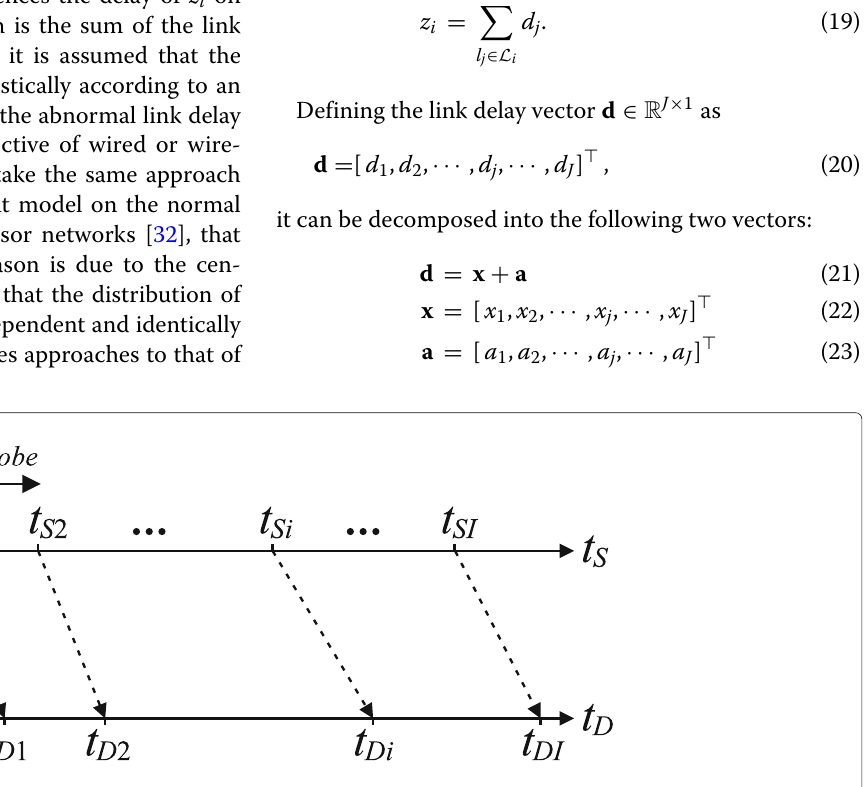
Fig. 3 Time chart between S and